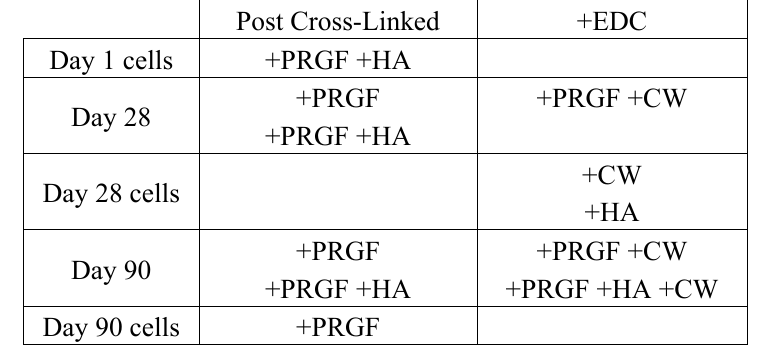
Table 4. Scaffolds with significant increases ( p < 0.05) in absorbance values when comparing cross-linking